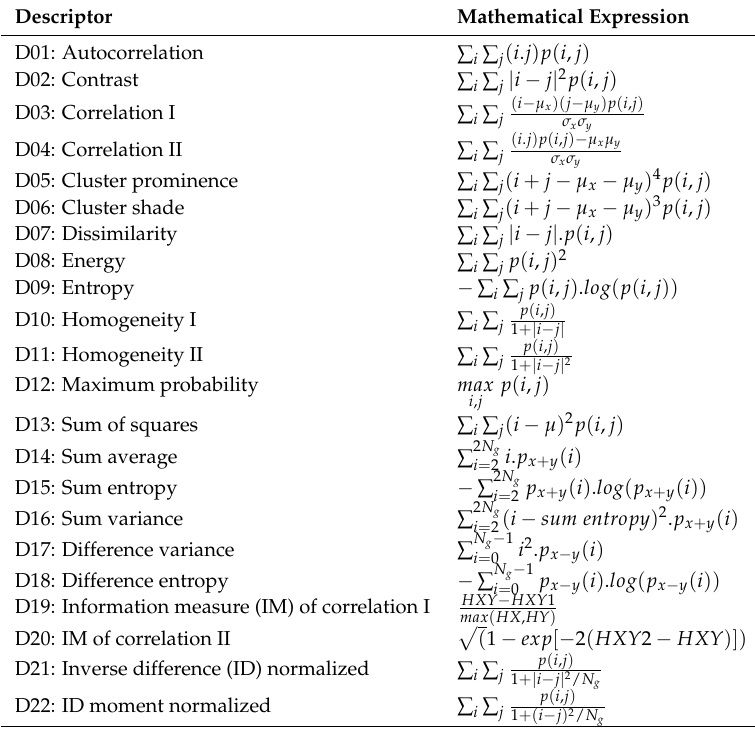
Table 1. Descriptors computed from the